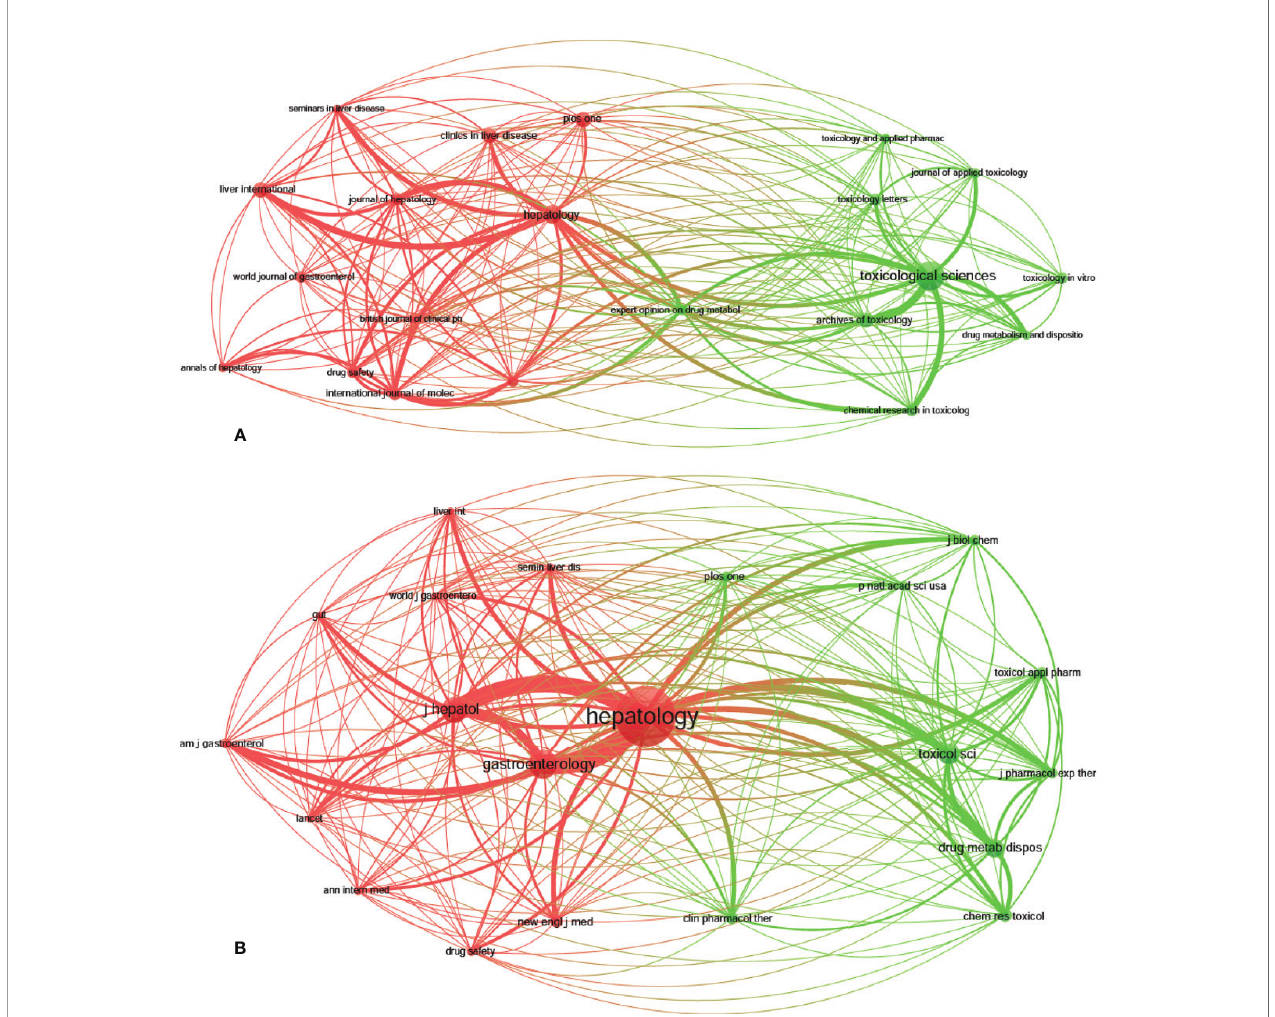
FIGURE 4 | The network map of academic journals ( A , T = 21) and co-cited academic journals ( B , T=700) for drug-induced liver injury (DILI)